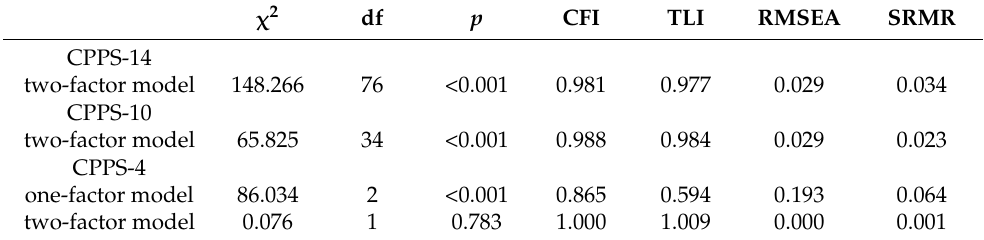
Table 2. Goodness of fit indexes for the proposed CPSS models.